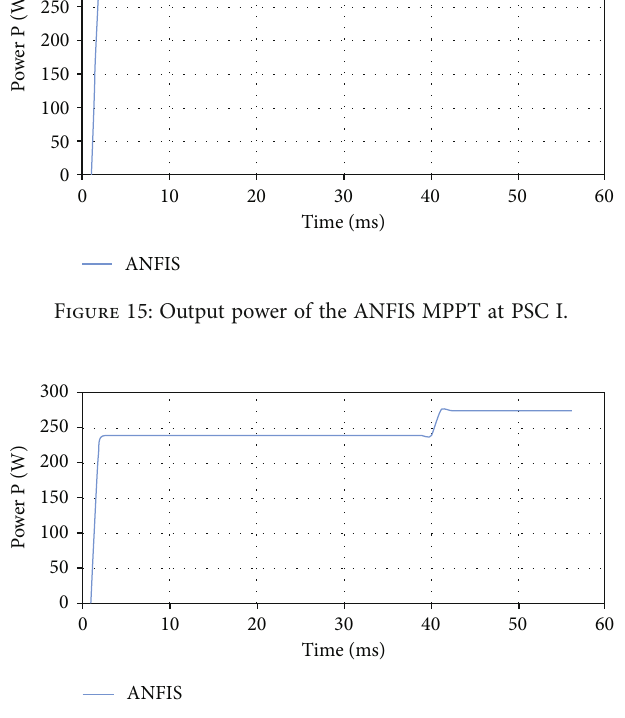
Figure 16: Output power of the ANFIS MPPT at PSC II.